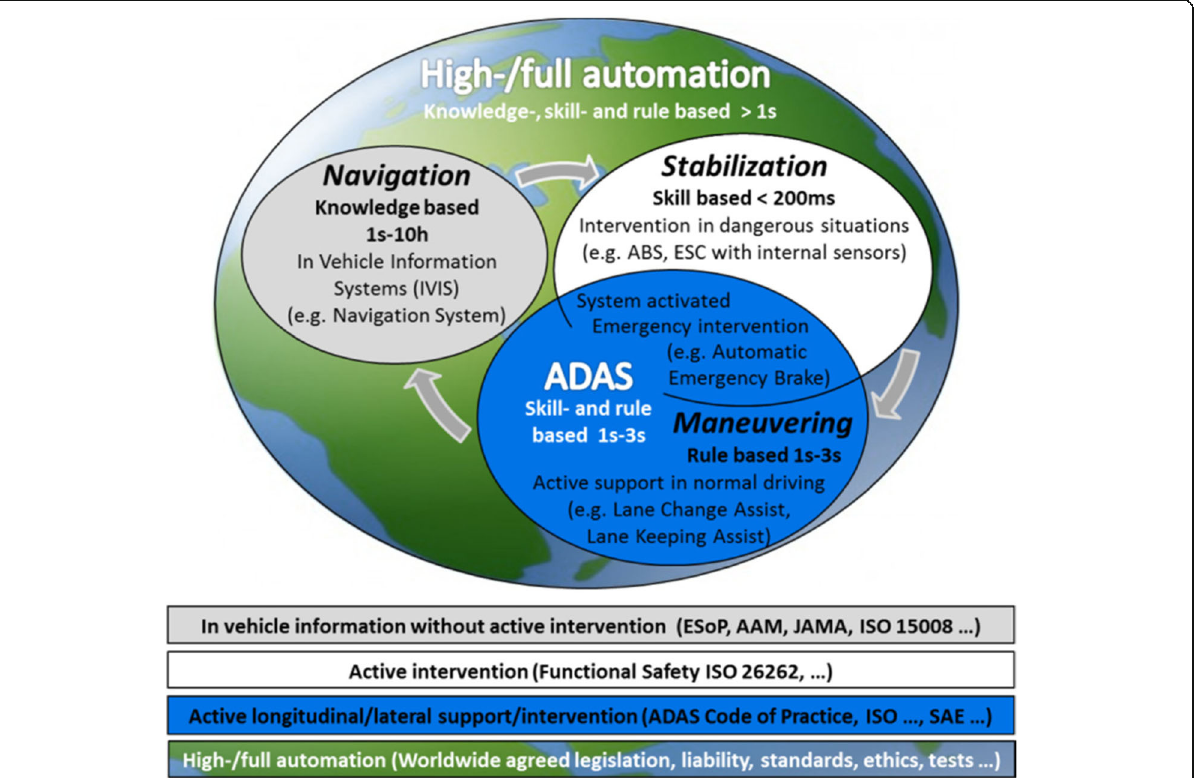
Fig. 3 Standards for different automation levels (high and full automation = outer oval) illustrated based on driving tasks (ADAS = blue oval)